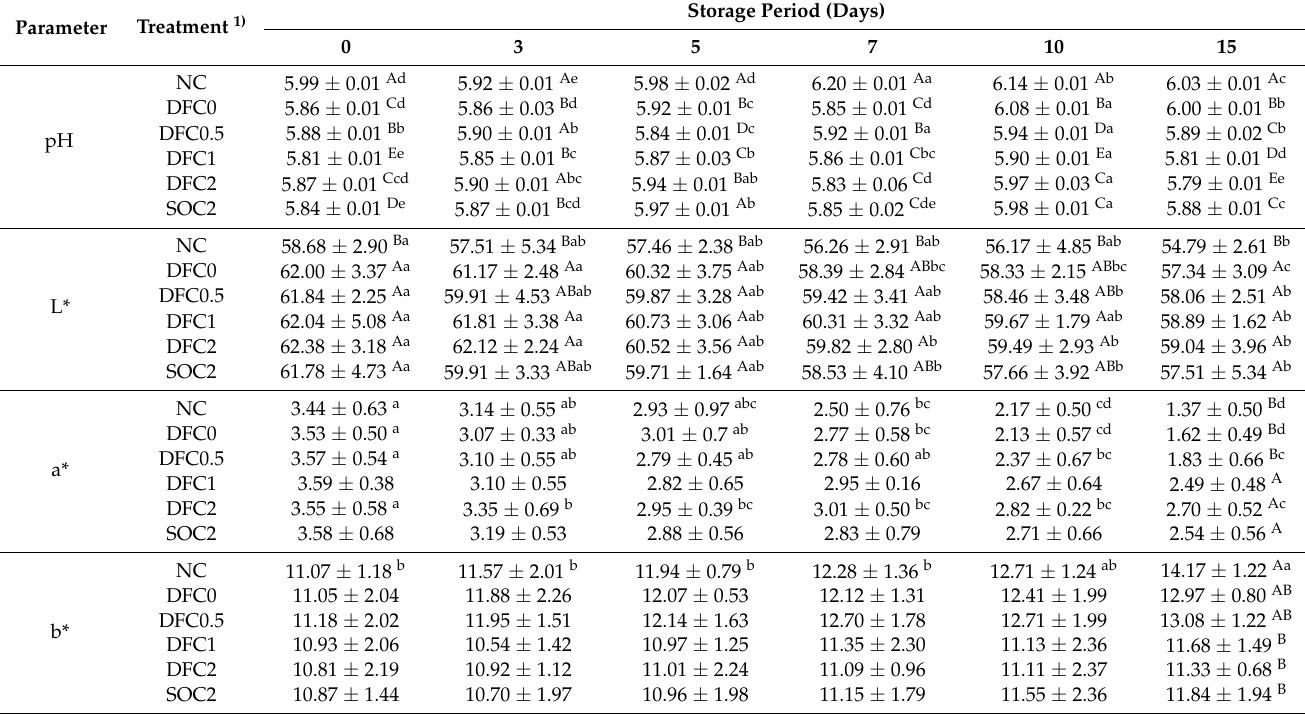
Table 1. pH and color of coated chicken meat during storage at 4 ± 1 ◦ C for up to 15